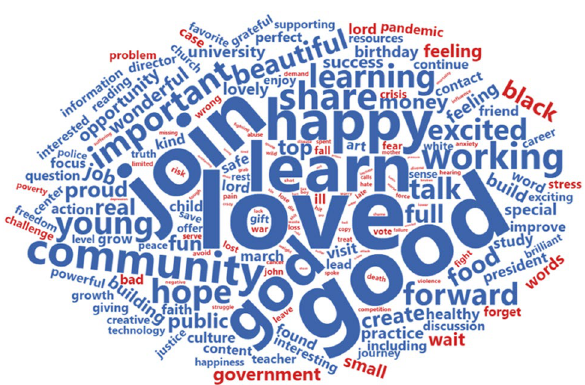
Figure 3. Words from the HF list that contributed most to positive and negative sentiment, shown in blue and red, respectively, and sized proportional to their frequency of occurrence. Some words, such as feeling, are colored in blue and red simultaneously because the repository regards them as holding both sentiment values. Graphic made by the authors, using R